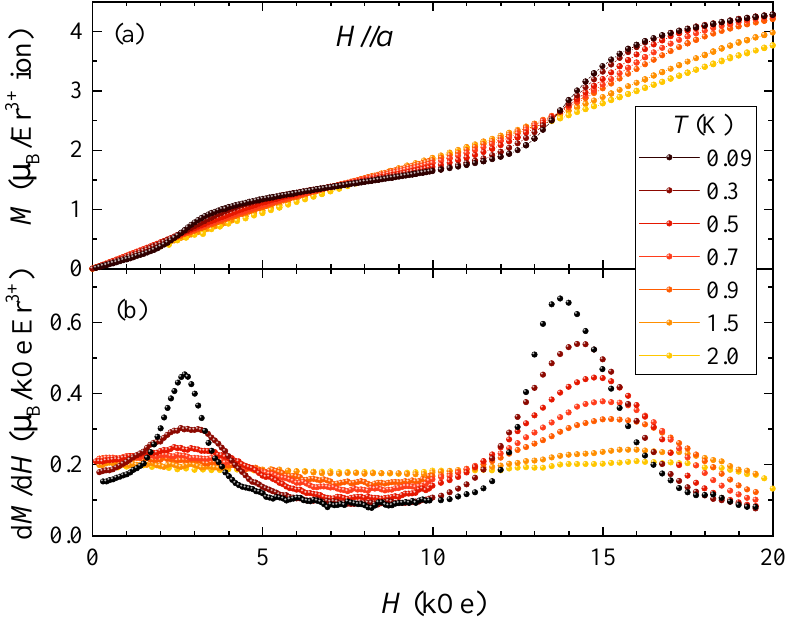
Figure 3: Field dependence of (a) magnetisation, M ( H ) , and (b) its derivative, dM / dH , measured in single crystal of the SrEr O for H (cid:107) a at different temper- 2 4 atures. The 1 / 3-magnetisation plateau is most pronounced at the lowest tempera- ture, but it remains clearly visible at temperatures well above the zero-field ordering = 0.75 temperature, T N